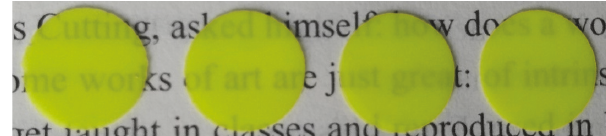
Figure 7: Green phosphor films with different concentrations (weight ratios phosphor: silicone = 0.4:1; 0.5:1; 0.6:1; 0.7:1).